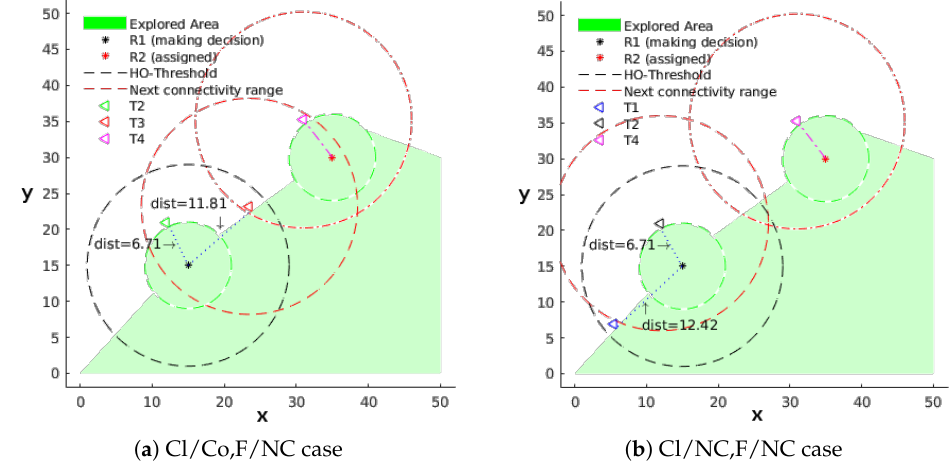
Figure 8. Two robots are carrying out an exploration mission. It is assumed that R 2 has already chosen the task T 4 whereas R 1 is still making its decision. The communication and sensory ranges are drawn around the robots with red and green dashed lines, respectively. Dotted lines are used to show the sight-line between R 2 and the tasks. The corresponding Euclidean distance is also shown. ( a ) [Cl/Co,F/NC] case: robot R 1 is selecting from targets T 2 that is the closest and keeps it connected and T 3 that is the furthest and cause a disconnection; ( b ) [Cl/NC,F/NC] case: robot R 1 is